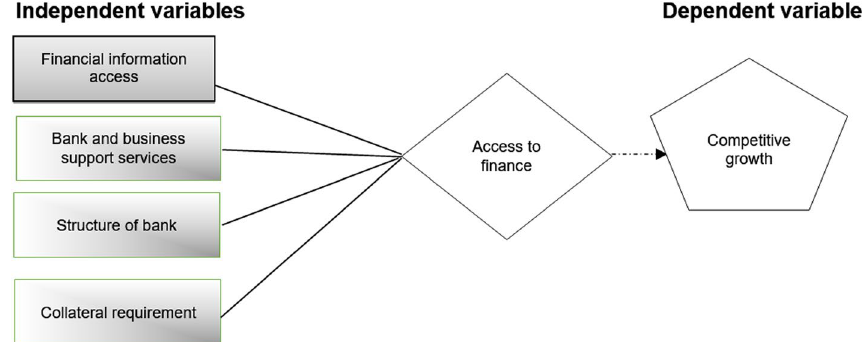
Fig. 1 Selected factors of access to